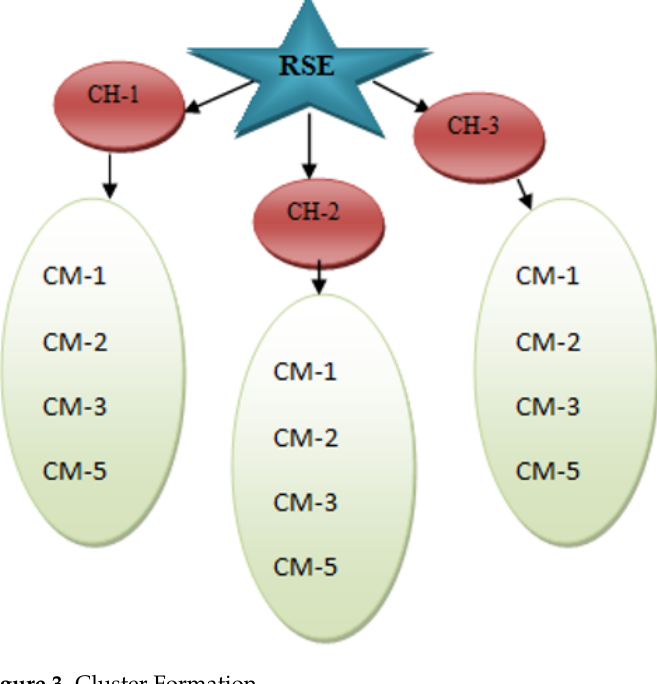
Figure 3. Cluster